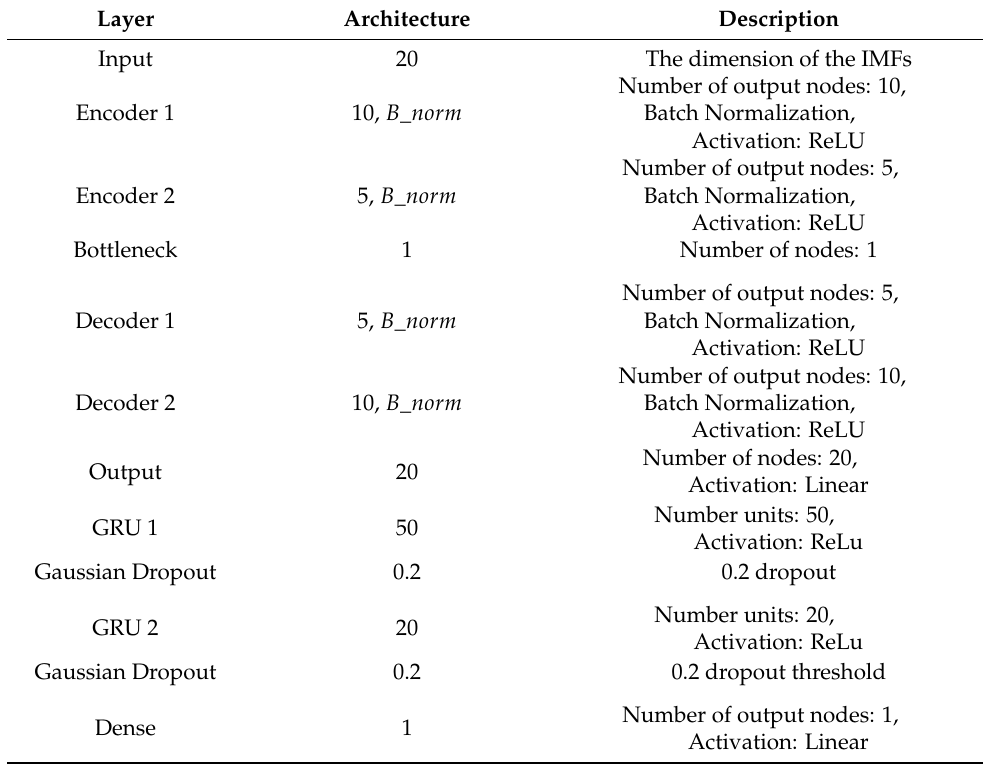
Table 1. Configuration of the proposed SAE-GRU architecture.